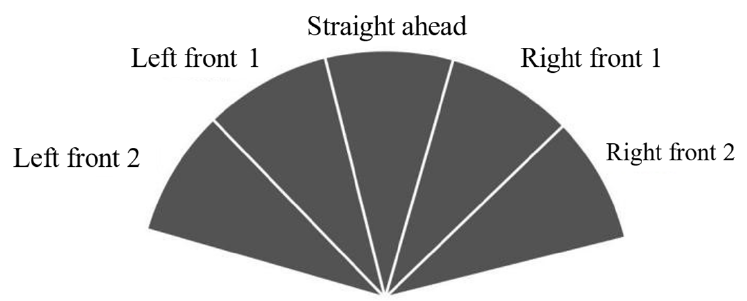
Figure 14. Direction division of the driving area.